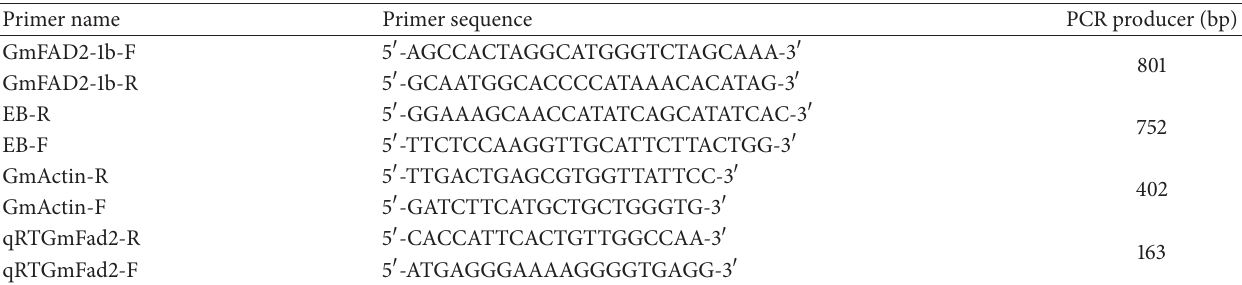
Table 1: Primers for different